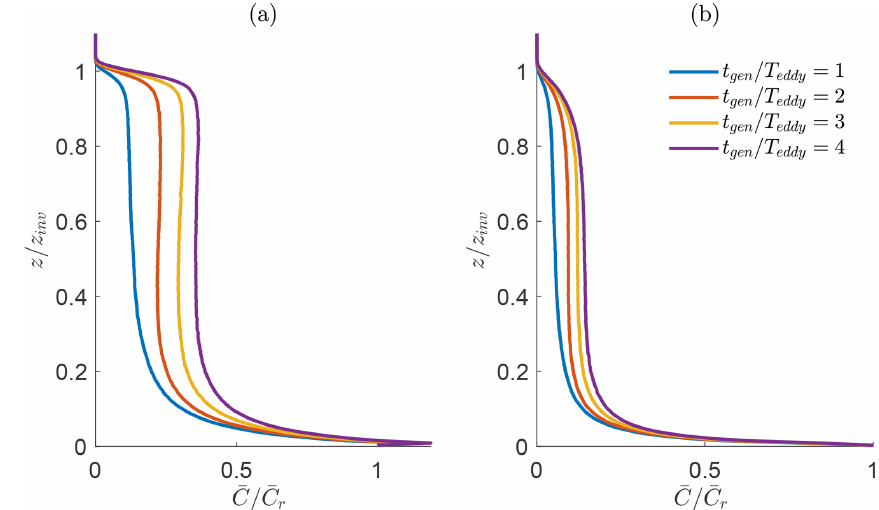
Figure 2. Normalized concentration profiles for (a) 10µm and (b) 50µm diameter aerosols at intervals of t gen /T eddy . The term t gen is the time since the initiation of surface aerosol generation; T eddy is the largest eddy timescale, a function of the inversion height and convective velocity scale: it is approximately 12min.